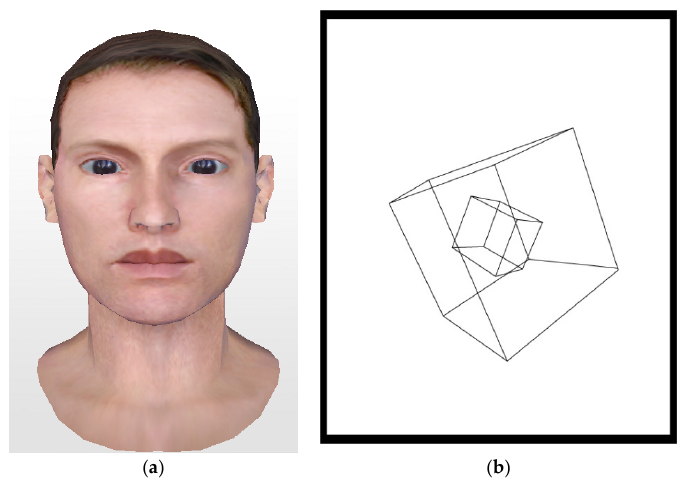
Figure 2. Virtual human ( a ) and the graphical shape ( b ) in the present study. The monitor was positioned so that the virtual human or the graphical shape was oriented to the task screen, not to the participant, and was located about 4 feet (~1.2 m) from the task monitor and about 3.5 feet (~1 m) from the participant. This is also the location where the human observer would sit (see Figure 3).